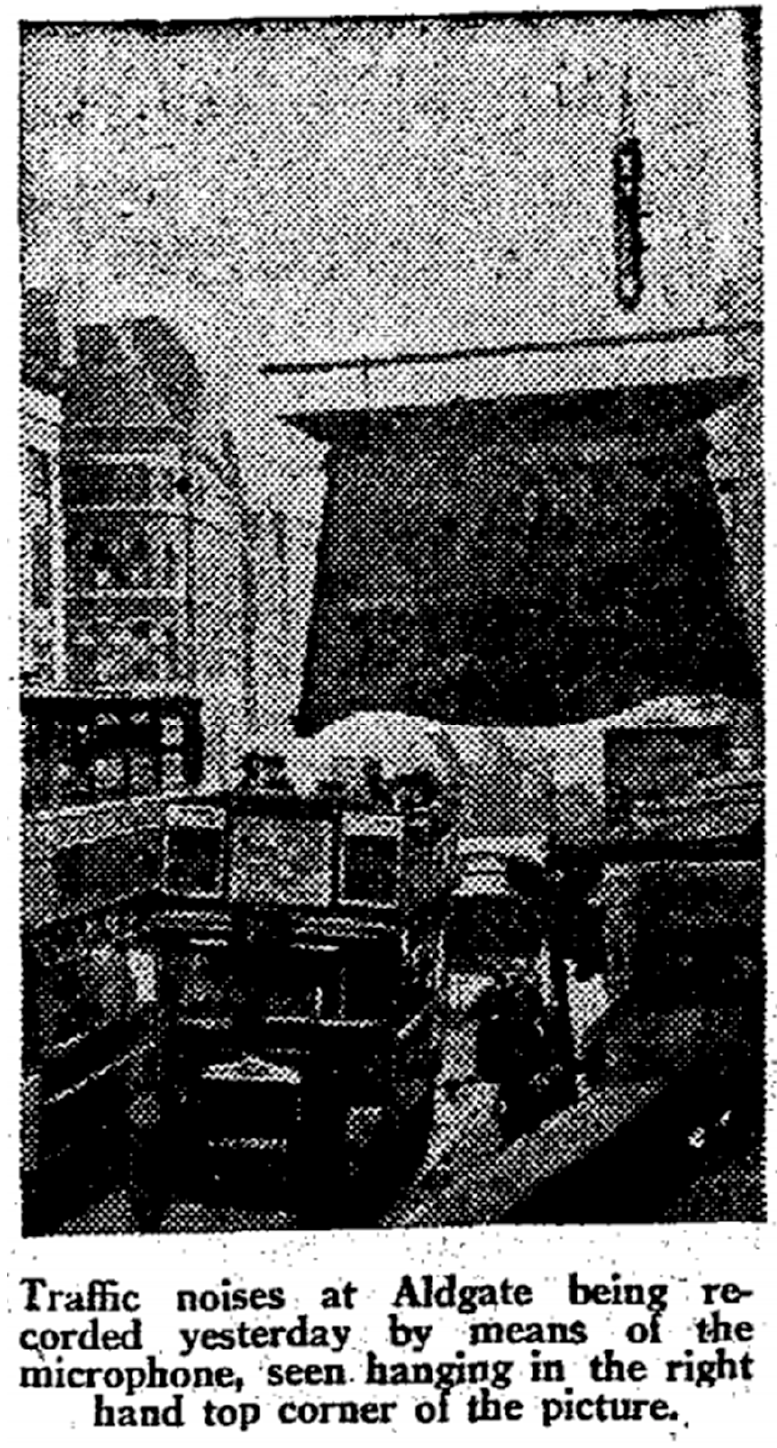
Figure 11. Aldgate—microphone location.